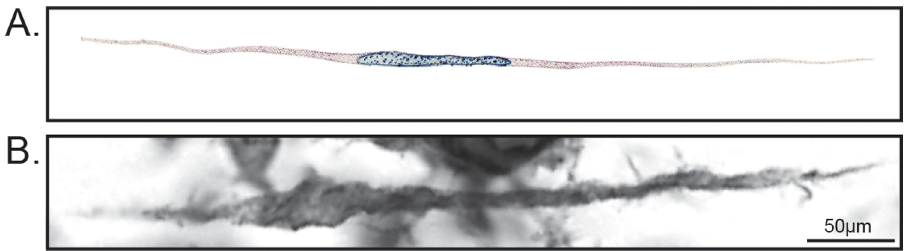
Figure 1. Rod microglia compared to Nissl’s Sta¨bchenzellen illustration. A) Franz Nissl’s illustration of Sta¨bchenzellen (rod cells) observed in patients suffering from syphilitic paralysis, as depicted by Spielmeyer [5]. B) Representative Iba1-positive rod microglia in the sensory cortex 7 days post-FPI, cell length:cell width ratio of 12:1. Note the similarities in the morphological characteristics between the two images.